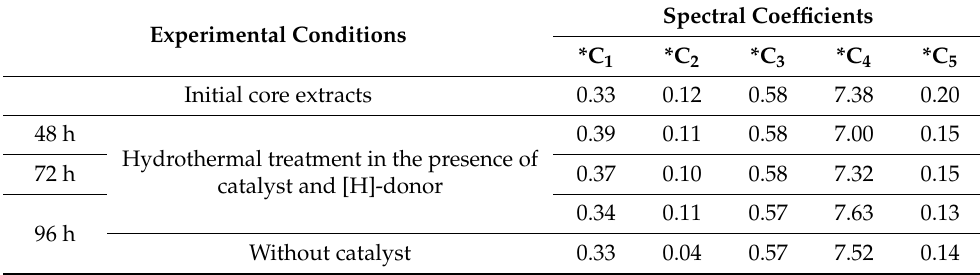
Table 4. FT-IR spectrometric indices of crushed core extracts. Experimental